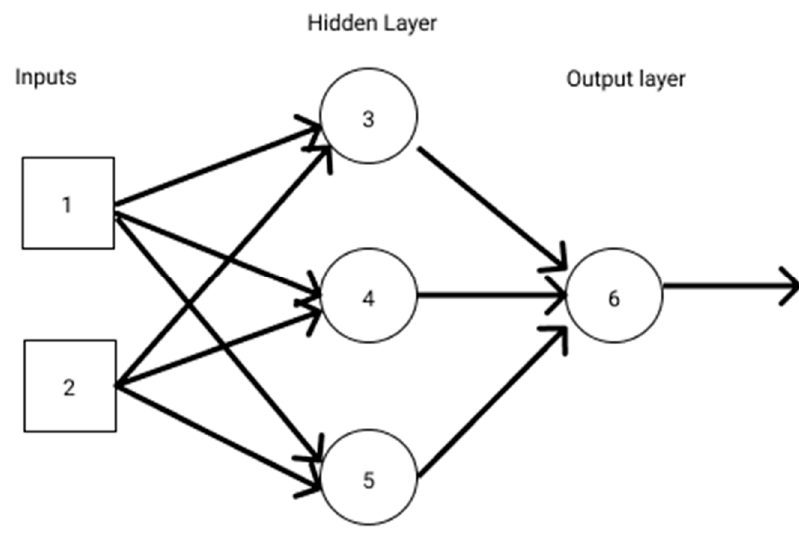
Figure 2. The architecture of a multilayer perceptron.